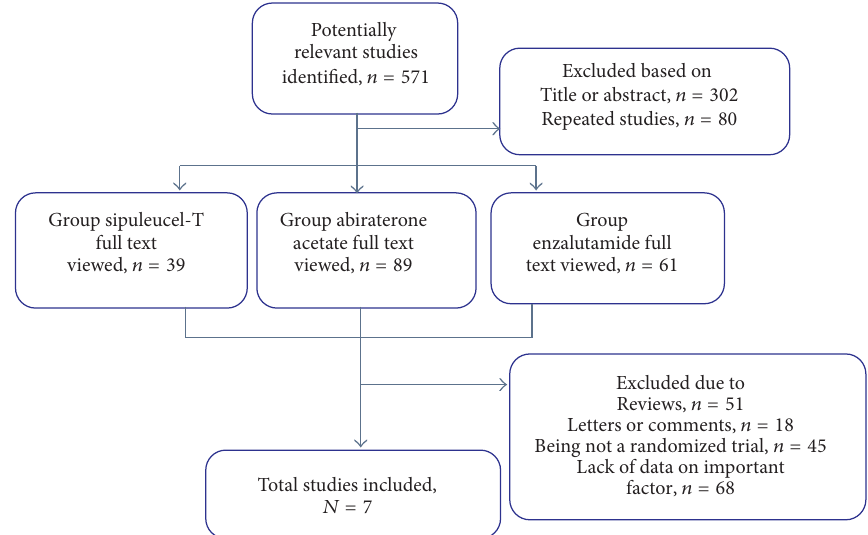
Figure 1: Flow chart of study selection. The summary of the study selection process was shown by flow chart.